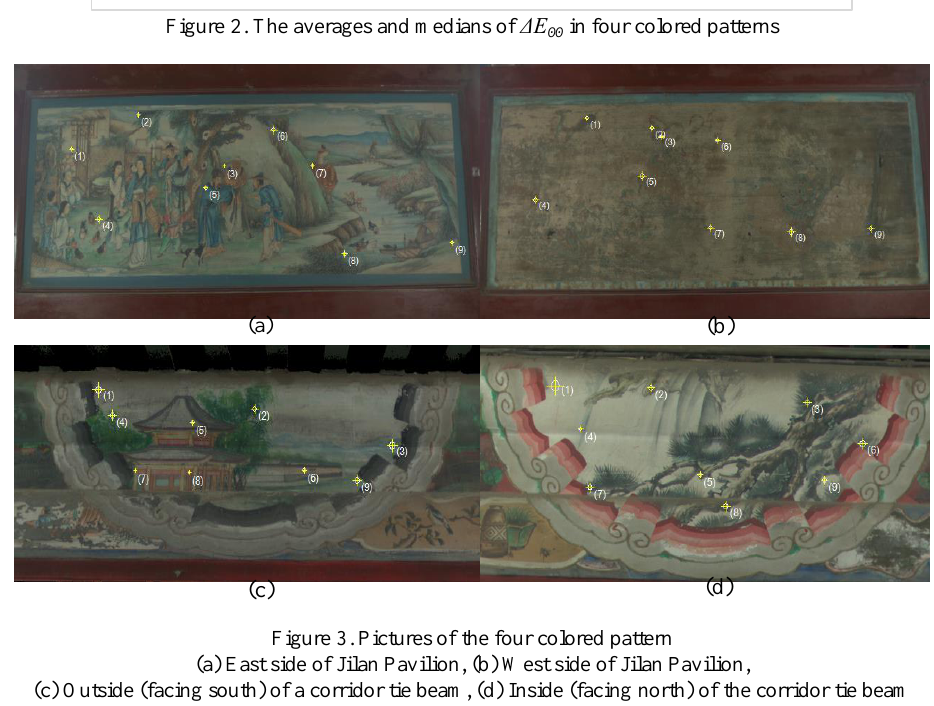
Figure 3. Pictures of the four colored pattern (a) East side of Jilan Pavilion, (b) West side of Jilan Pavilion, (c) Outside (facing south) of a corridor tie beam, (d) Inside (facing north) of the corridor tie